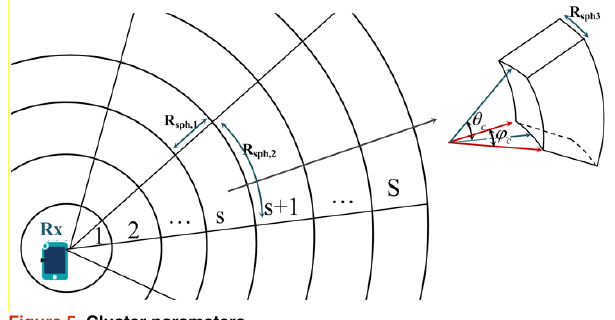
Figure 5. Cluster